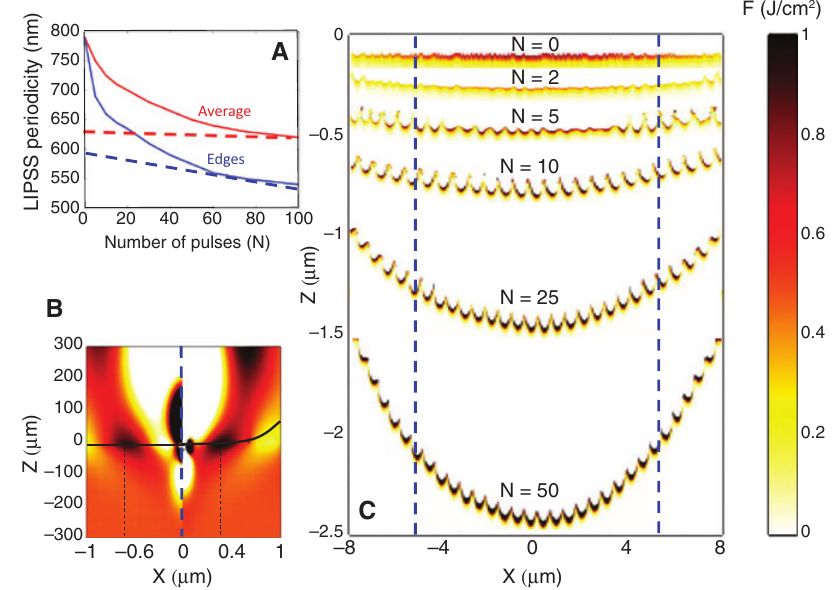
Figure 4: Evolution of surface relief under multipulse irradiation. (A) Ripple periodicity averaged along all interface (red solid line) and at the edges of the crater (blue solid line) as a function of the number of pulses. The dashed lines indicate the period saturation values. (B) Electric field distributions on a plane metal–air surface (left) and on a curved interface (right). The scale is the same as in Figure 2C. (C) Absorbed energy distribution after irradiation of N pulses of a stainless steel surface with pristine roughness (holes of radius R = 10 nm and average spacings d = 100 nm). The laser fluence is 0.5 J/cm 2